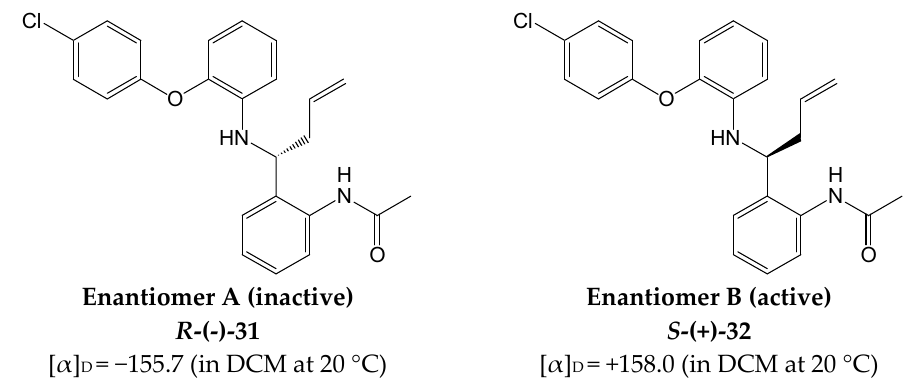
Figure 11. Enantiomers separated from compound 26 .